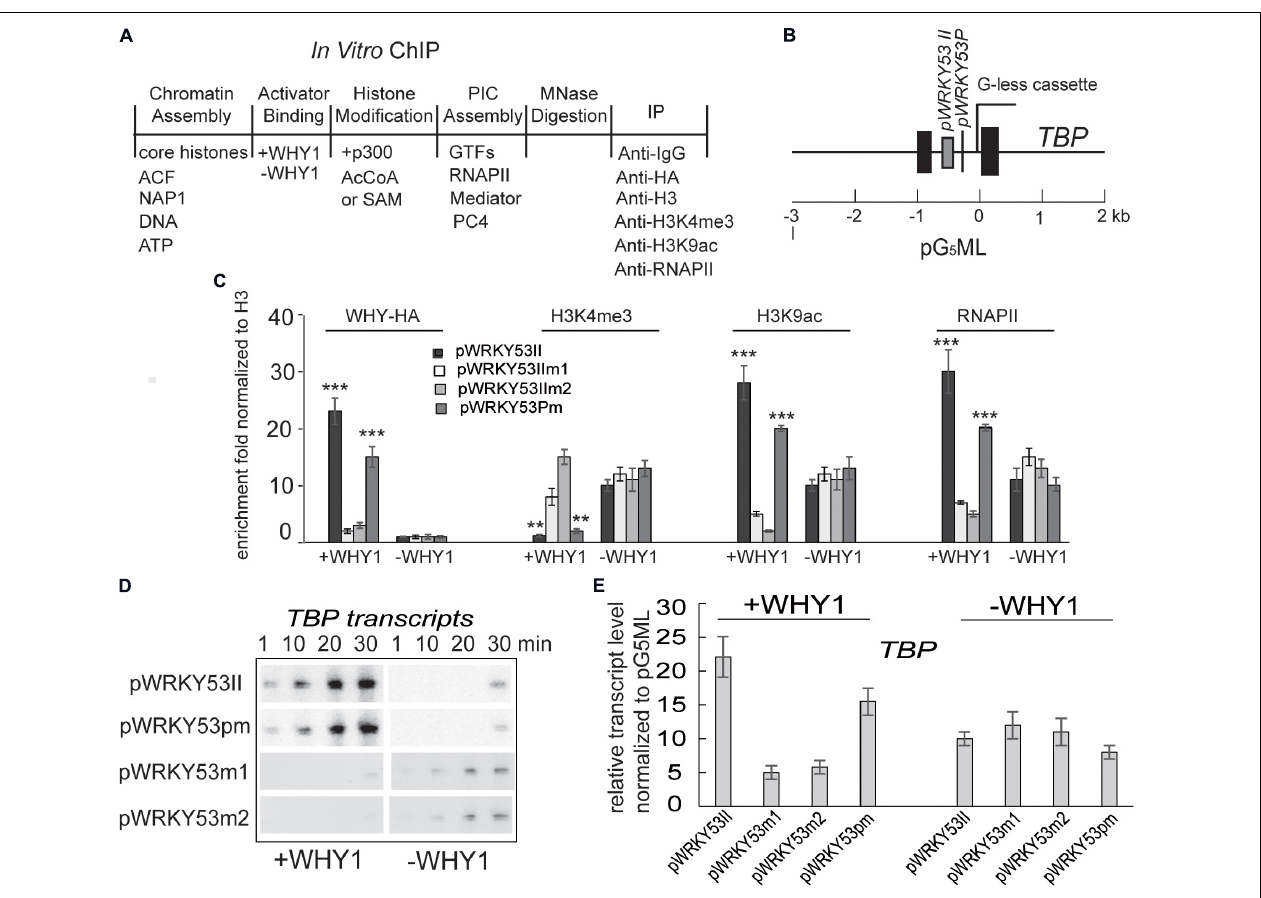
FIGURE 4 | WHIRLY1 impacts H3K4me3, H3K9ac levels on WRKY53 promoter in vitro. (A) Schematic of the in vitro ChIP assays. (B) Schematic of the pG5ML template indicating the amplicons used for qRT-PCR. (C) In vitro ChIP was performed with assembled chromatin. Chromatin was incubated with or without recombinant WHIRLY1 protein expressed in E. coli (Miao et al., 2013) acetylated by p300 or methylated by S -adenosyl-l-methionine (SAM), digested with MNase, and immunoprecipitated with antibodies against WHIRLY1, H3, H3K4me3 or H3K9ac, or RNAPII (A) . The ChIP-quantitative PCR was carried out using primer containing WHIRLY1 binding sites (WRKY53II) and TATA box. H3K4me3 and H3K9ac levels were relative to H3 levels. Three biological replicates and three technique replicates were used to analyze. Asterisk indicate significant differences ( ∗∗ P < 0.01 and ∗∗∗ P < 0.001) based on Student’s t -test. Error bars represent SE. (D) The report gene transcription by run-on assay. (E) The report gene transcription level by qRT-PCR. Three biological replicates and three technique replicates were used to analyze. Error bars represent